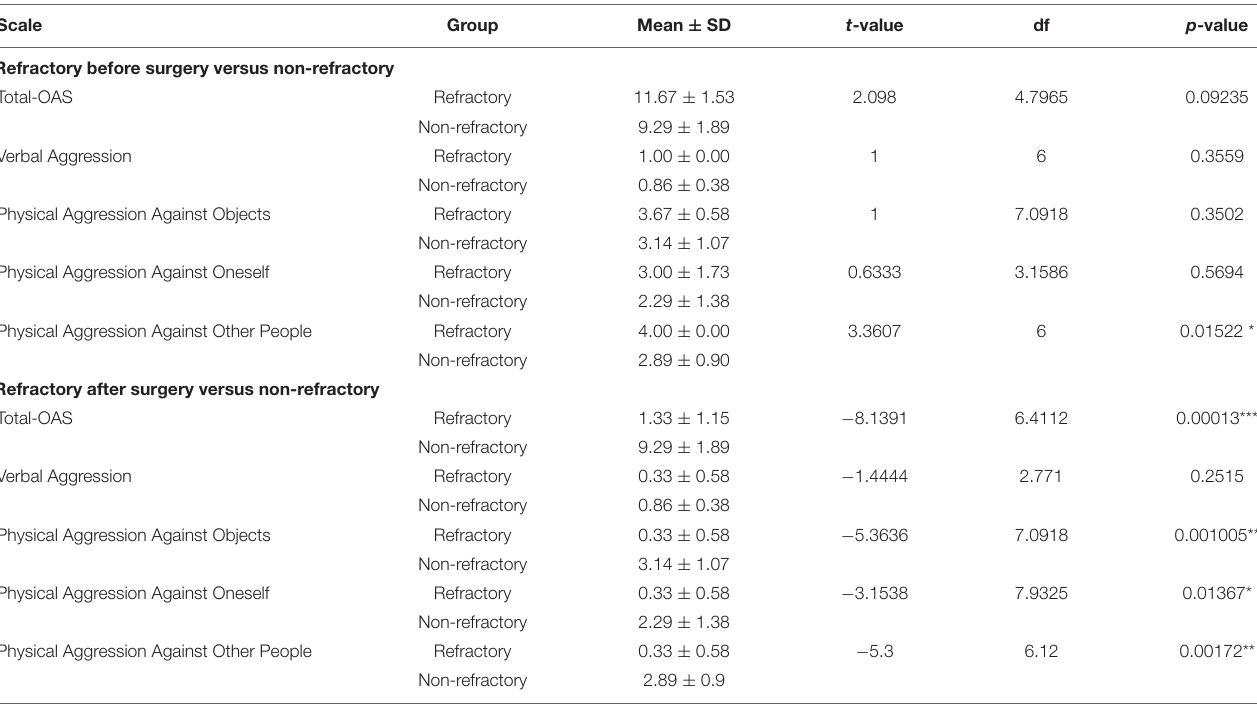
TABLE 2 | Overt Aggression Scale (OAS)